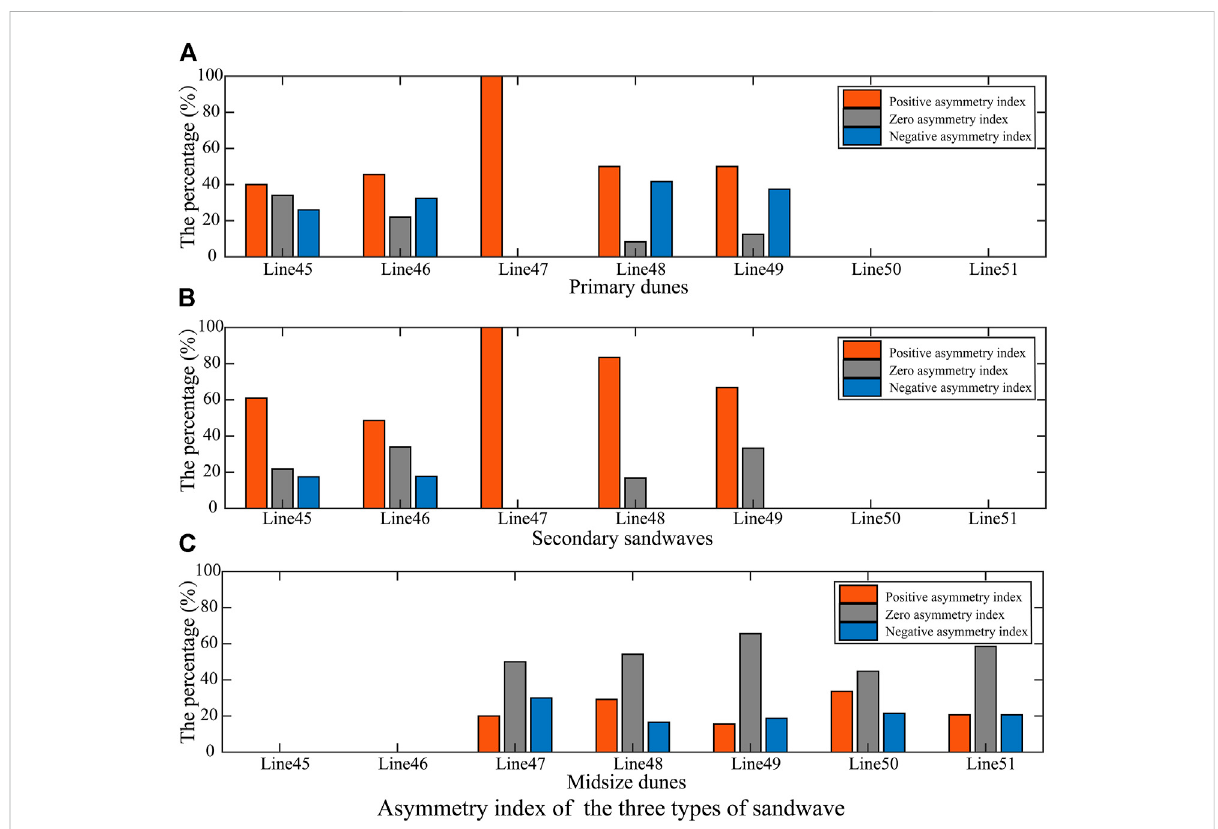
FIGURE 5 Histogram of frequency distribution of the asymmetry index (AI) of (A) primary dunes, (B) secondary sandwaves and (C) midsize dunes on each of the 7 sections of the survey line. The red represents the positive asymmetry index and blue represents the negative asymmetry index. The neutral index, in grey color, is de fi ned as values between − 1 2 ( AI max − AI min ) 10 to 1 2 ( AI max − AI min ) 10